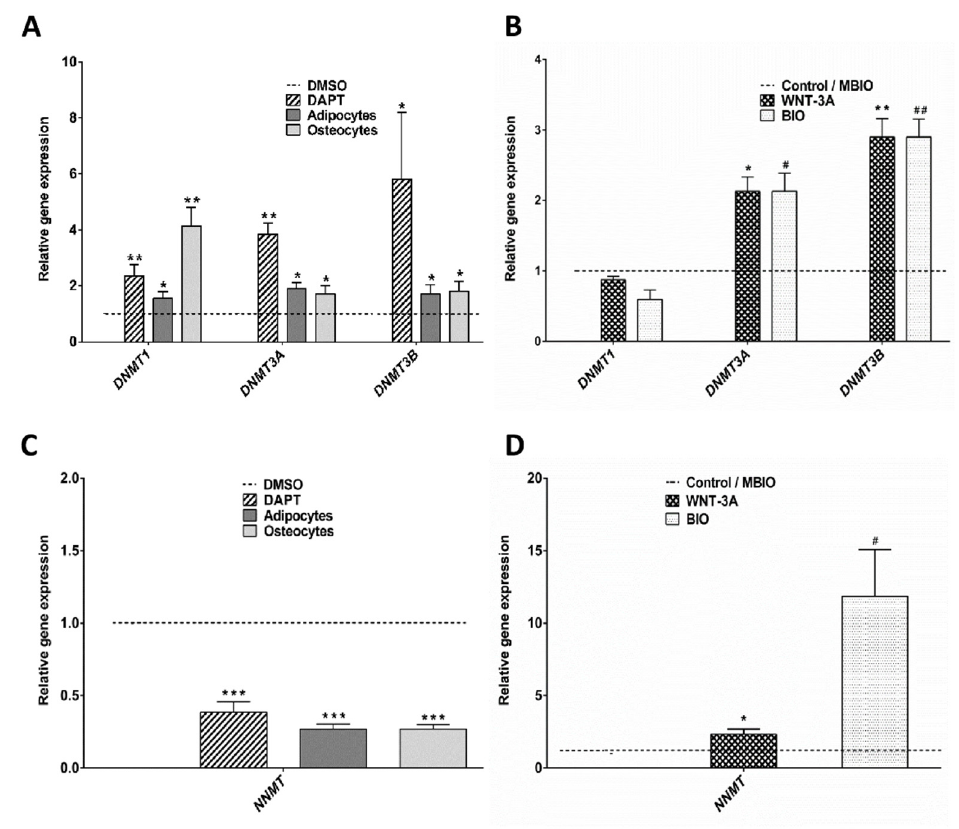
Figure 4. Notch and Wnt signaling a ff ect the expression of methyltransferases in DPSCs. ( A , B ): Q-PCR showing relative di ff erences in DNA-methyltransferases DNMT1, DNMT3A and DNMT3B expression in DPSCs between control (DMSO, MBIO) and DAPT, BIO, WNT-3A, adipoinduction and osteoinduction conditions. Data are normalized to reference β -ACTIN and GAPDH levels and represented as the mean + SEM ( n = 3). ( C,D ): Q-PCR analysis showing relative di ff erences in transcript expression for the Nicotinamide-N-methyltransferase NMMT in DPSCs subjected to di ff erent treatments. Data are normalized to reference β -ACTIN and GAPDH levels and represented as the mean + SEM ( n = 3) *: p < 0.05; **: p < 0.01; ***: p < 0.001. Dunn’s Test, Kruskal- Wallis H Test. Asterisks (*) report significance with respect to controls PBS / DMSO, and Hash symbol (#) represents significance with respect to control MBIO. #: p < 0.05; ##: p <